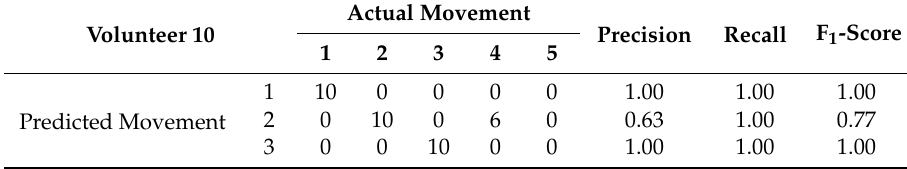
Table A10. Results Volunteer